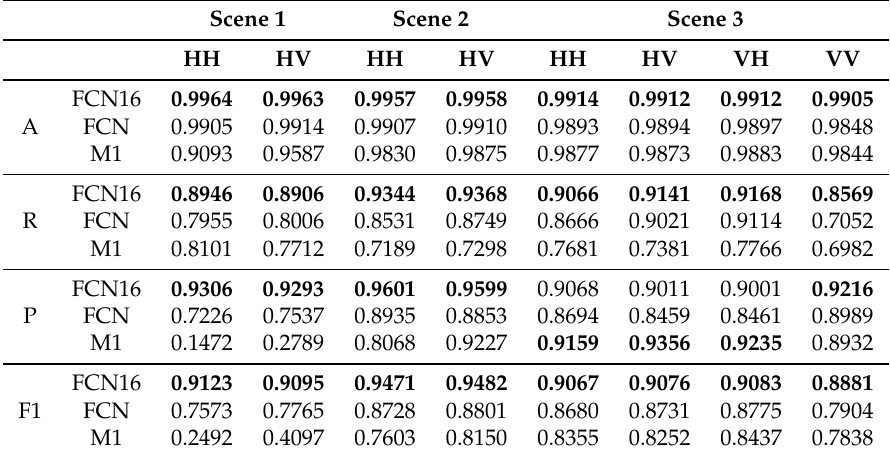
Table 4. The indices of three different methods. A is accuracy, R is recall, P is precision, and F1 is F1 score, given in Equation (3). The best results are in bold.